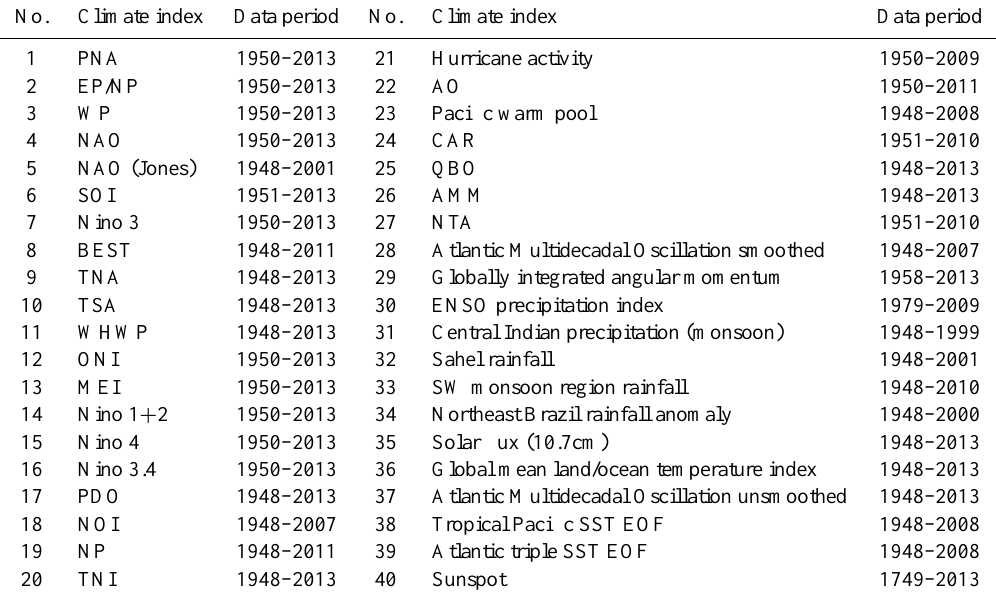
Table 1. Primary selection of atmospheric circulation